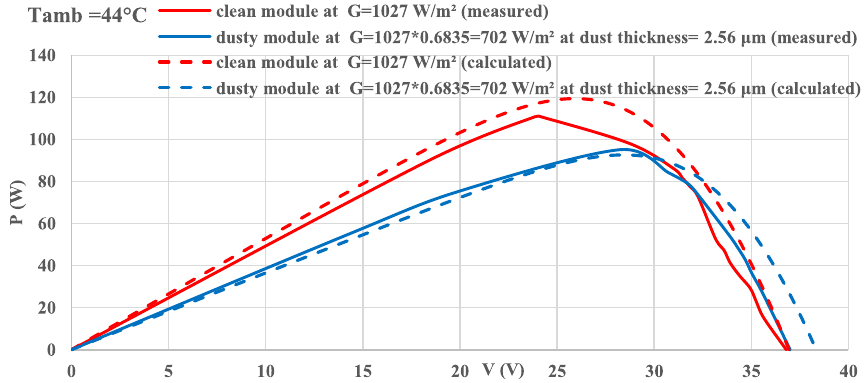
Fig. 12 Measured using HT204 solar radiation meter and calculated power‑voltage characteristic curves of dusty and clean modules at measured ambient incident radiation of 1027 W/m